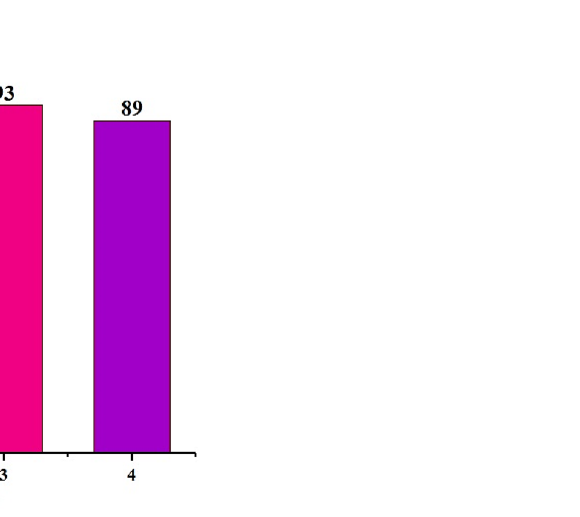
Figure 12. Hot filtration of Fe 3 O 4 @CPTMO-phenylalanine-Ni.